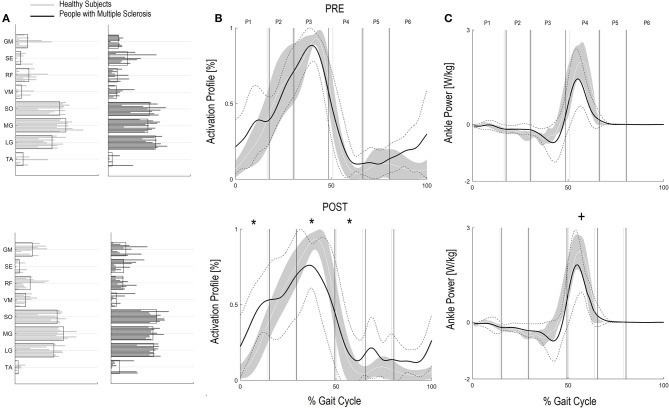
Forward Propulsion Muscle Synergies (FPM) and Kinetics of Ankle joint. Weightings (A) and activation profile (B) of FPM and ankle power curve (C) for persons with multiple sclerosis (PwMS) pre (top panel) and post (bottom panel) treatment and speed-matched healthy subjects (HS). In (B,C) The solid black line represents the averaged profile of PwMS and the dashed black lines represent ± SD of PwMS curves. Vertical lines (solid gray line—healthy subjects and solid black line—PwMS) indicate the six phases of a normalized gait cycle (P1, early stance; P2, mid stance; P3, terminal stance; P4, pre swing; P5, early swing; P6, late swing). Range of HS normality is reported in gray. *p < 0.05 at paired t-test of Z-score, pre- vs. post-treatment, for activation percentage index of FPM (B) or peak ankle power parameter (C) in PwMS. +0.05 < p < 0.1 at paired t-test of Z-score, pre- vs. post-treatment, for activation percentage index of FPM (B) or peak ankle power parameter (C) in PwMS.